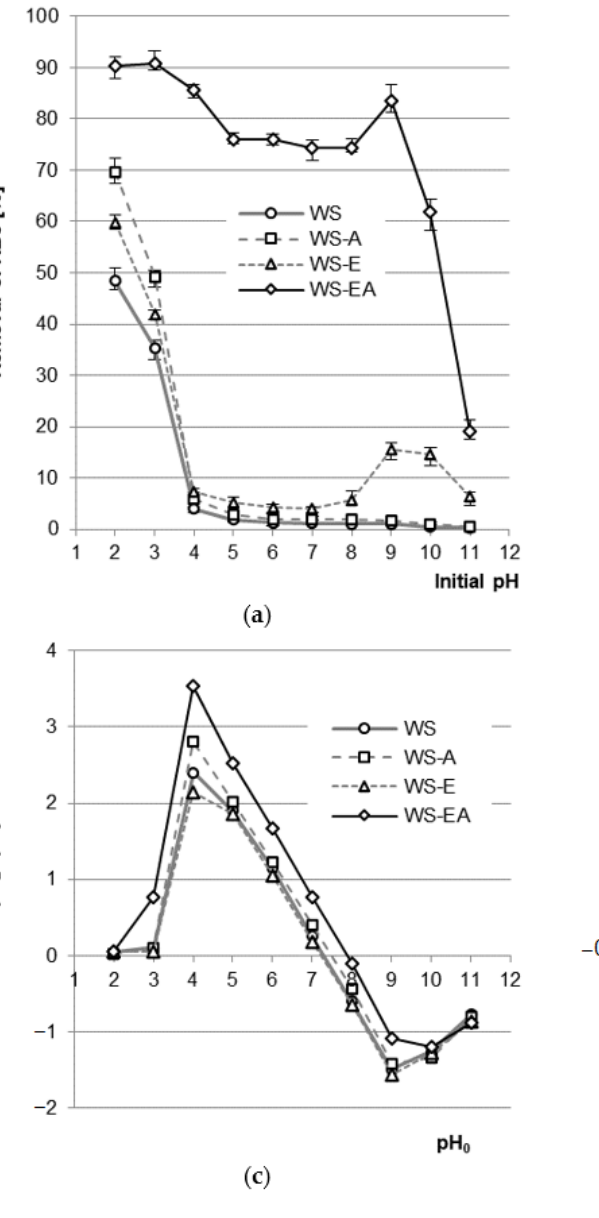
Figure 3. ( a ) Effect of pH on the efficiency of RB5 sorption on tested sorbents (average + range). ( b ) Effect of changes in solutions’ pH after sorption (median + range). ( c , d ) pH PZC of the sorbents determined with Boehm’s titration method. Conc. of the solution: 50 mg RB5/L, dose of the sorbent:5 g/L, mixing speed: 150 r.p.m., sorption time: 60 min, temp. 22 °C.